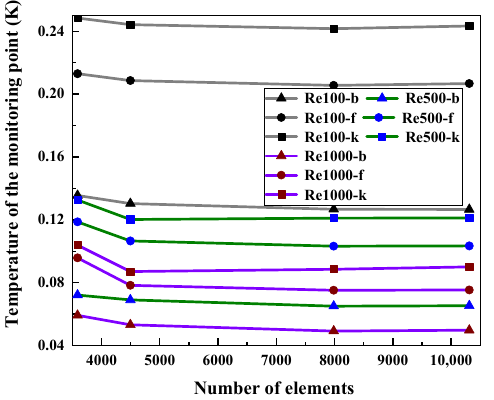
Figure 2. Effect of the number of elements on the temperature at three different monitoring points (b, f, k) in the simulation area at Reynolds numbers of 100, 500, and 1000.